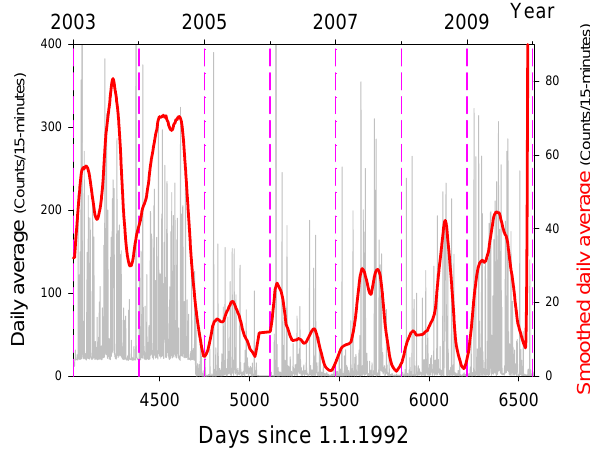
Figure 2: Overview of the span of the recorded data and the implementation of the different sensors